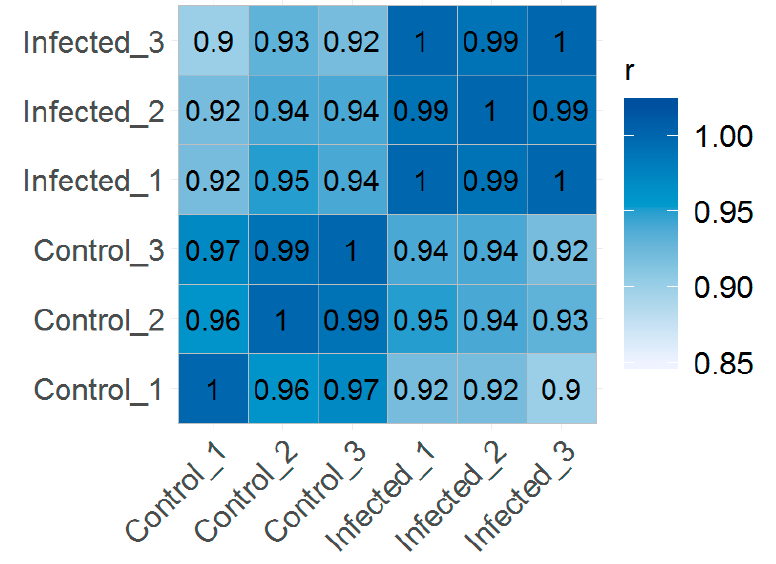
Figure 2. Global correlation analysis. Heatmap showing Pearson’s correlation coe ffi cient ( r ) for TPM normalized values across samples, indicating positive correlation between biological replicates.